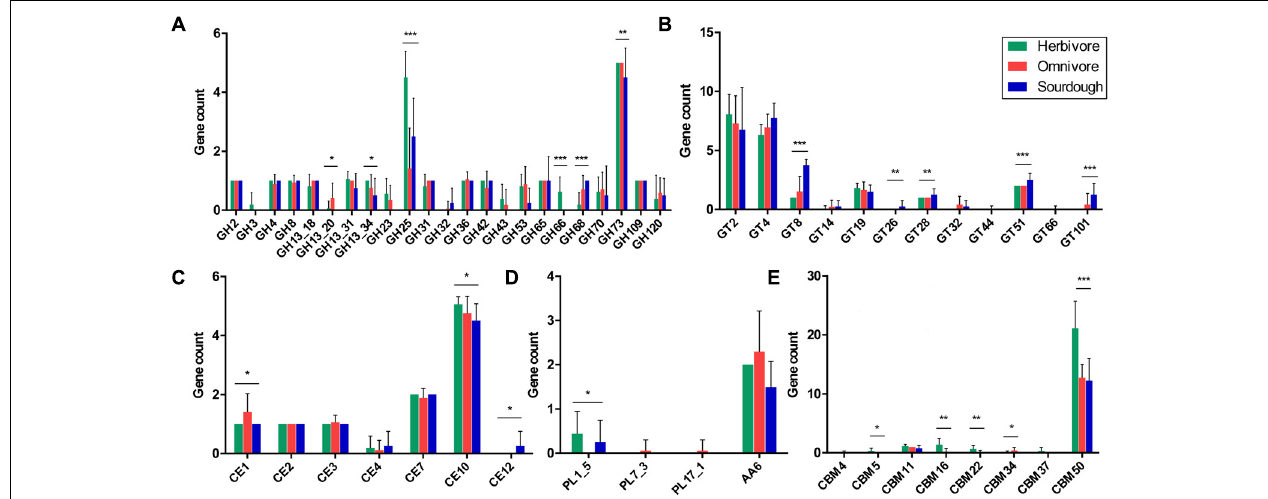
FIGURE 7 | Distribution and abundance of active carbohydrate enzyme family genes in Lactobacillus reuteri strains isolated from herbivores, omnivores, and sourdough. (A) Glycoside hydrolase (GH) family genes. (B) Glycosyltransferase (GT) family genes. (C) Carbohydrate esterase (CE) family genes. (D) Polysaccharide lyase (PL) and auxiliary activity (AA) family genes. (E) Carbohydrate-binding module (CBM) family genes. ∗ p < 0.05, ∗∗ p < 0.01, ∗∗∗ p < 0.001.